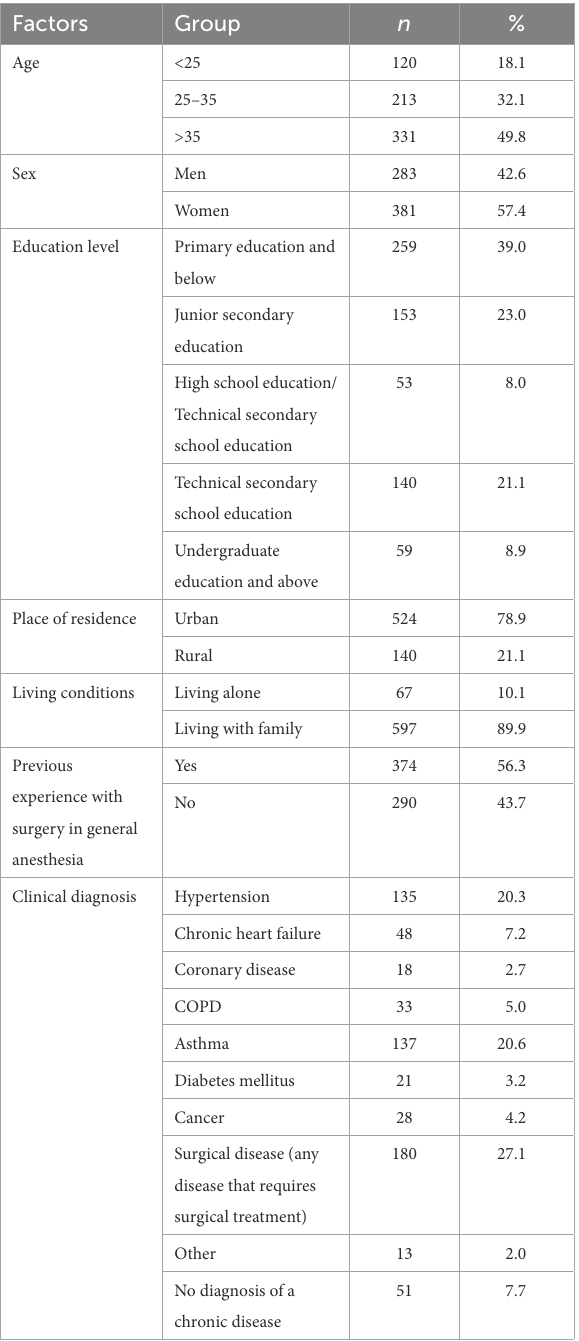
TABLE 1 Frequency distribution of demographic characteristics ( n = 664).